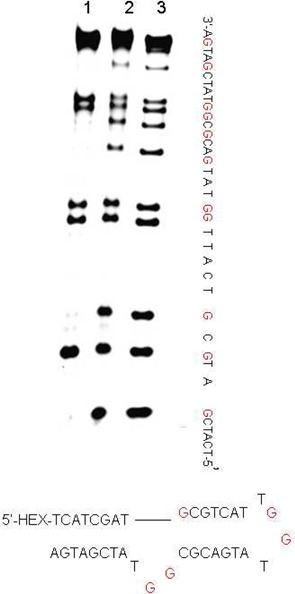
Polyacrylamide gel electrophoresis analysis of 38mer-DNA containing hairpin loop and bulge structures. Lane 1: ODN was oxidized by 20 mM K2WO4 and 200 mM H2O2 for 5 min; lane 2: ODN containing 80% formamide was oxidized by 20 mM K2WO4 and 200 mM H2O2 for 5 min; lane 3: ODN was treated with DMS.